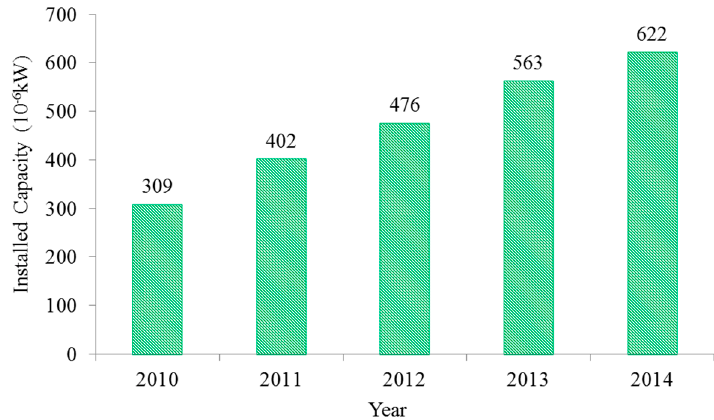
Figure 3. The changing tendency of the wind power installed capacity.